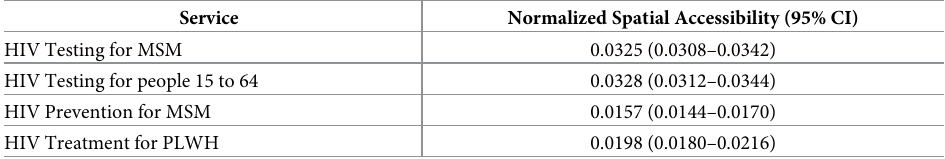
Table 1. Spatial accessibility of HIV testing, treatment, and prevention services in